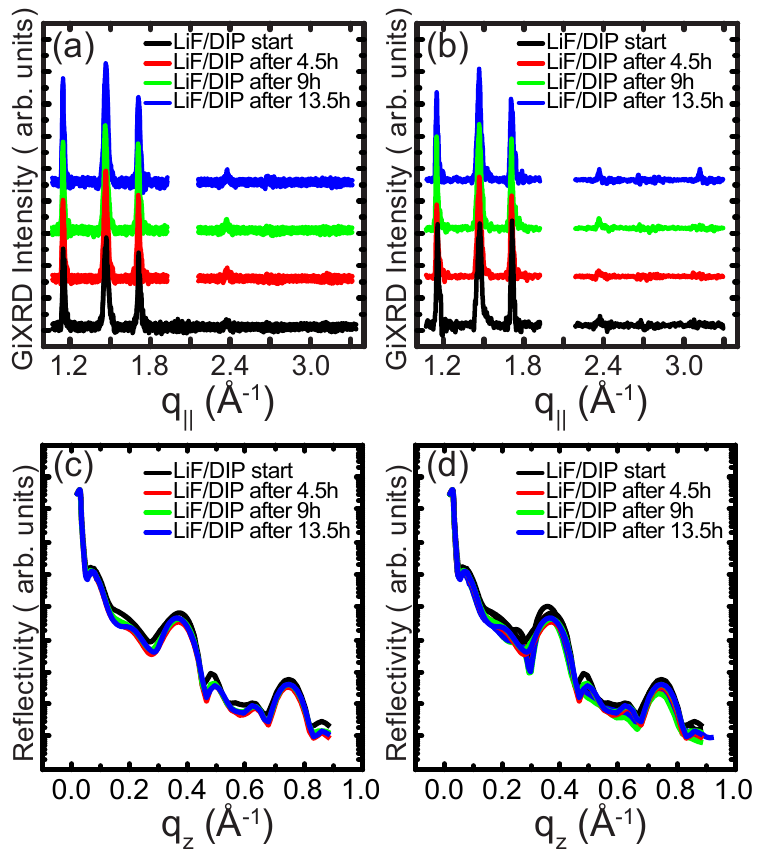
Figure 5. ( a , b ) In-plane and ( c , d ) specular XRD data of DIP ( a , c ) and LiF/DIP ( b , d ) split sample. The samples were heated for the labeled time at 90